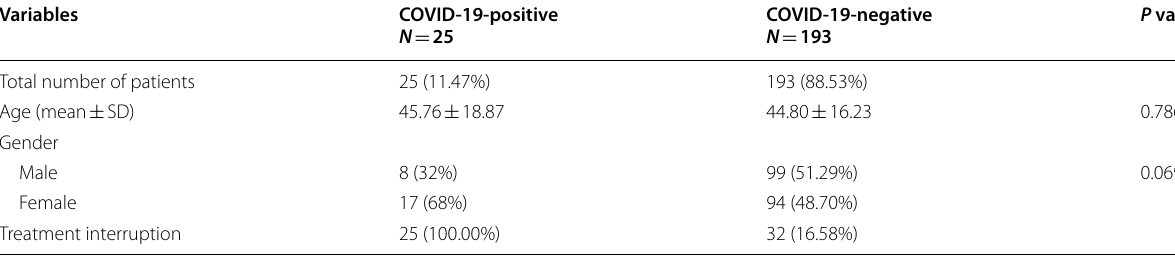
Table 1 Demographic variables of radiotherapy beneficiaries